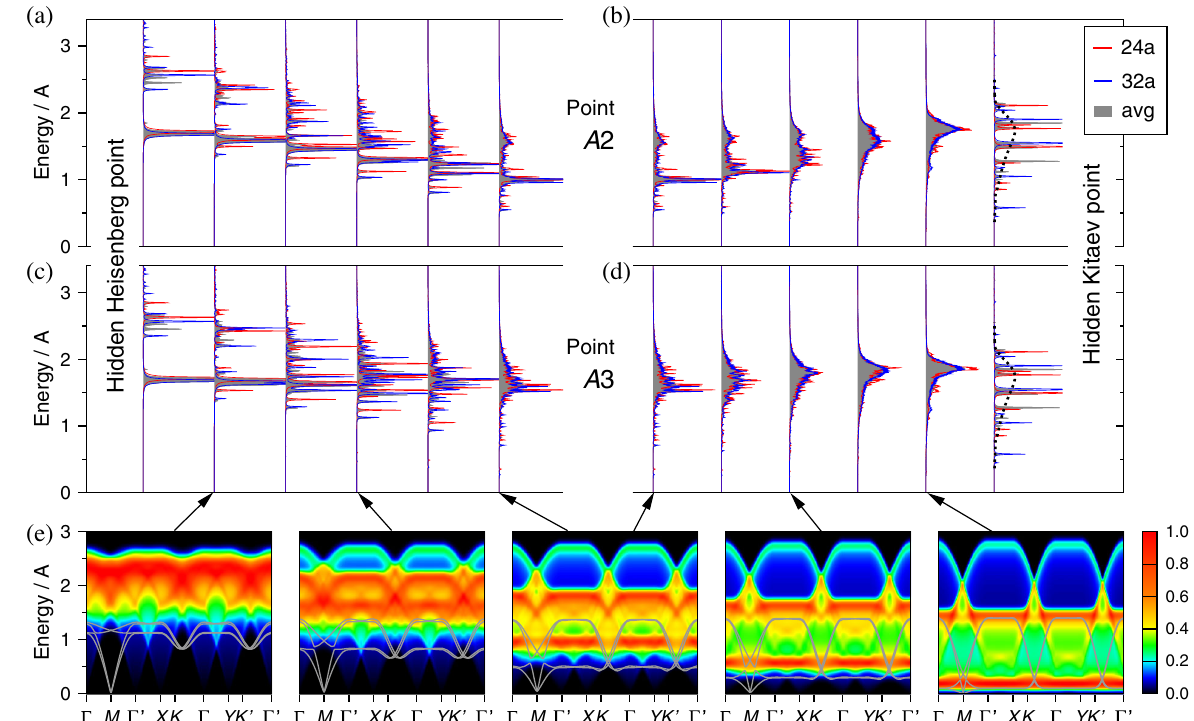
FIG. 6. (a) Evolution of the theoretical Γ -point ( q ¼ 0 ) RIXS intensity on a line through the parameter space going from the hidden Heisenberg point ð J; K; Γ ; Γ 0 Þ ≈ ð − 0 . 1 ; − 0 . 6 ; 0 . 8 ; − 0 . 4 Þ A to the point A 2 of Fig. 3. The line lies completely in the zigzag phase. Finite- size effects can be estimated by comparing data for various clusters shown in Appendix B. The average is taken over all of them (i.e., 24a, 32a, and 32b1 to 32b3). The spectra are presented in units of the energy scale A and only a tiny broadening is used to resolve the structure of the continuum. (b) The same for a line connecting the point A 2 and the hidden Kitaev point ð J; K; Γ ; Γ 0 Þ ≈ ð 0 . 6 ; − 0 . 5 ; 0 . 6 ; − 0 . 3 Þ A . Apart from the last point, the ground state remains zigzag ordered. The dotted line indicates scaled exact solution in the AFM Kitaev limit [63]. (c,d) Same as panels (a,b) but for the A 3 point of Fig. 3. (e) Two-magnon density of states for selected points of panels (c) and (d) calculated using the linear spin-wave dispersions (gray lines). Single zigzag pattern of Fig. 1(b) was assumed, its Bragg spots correspond to the Y